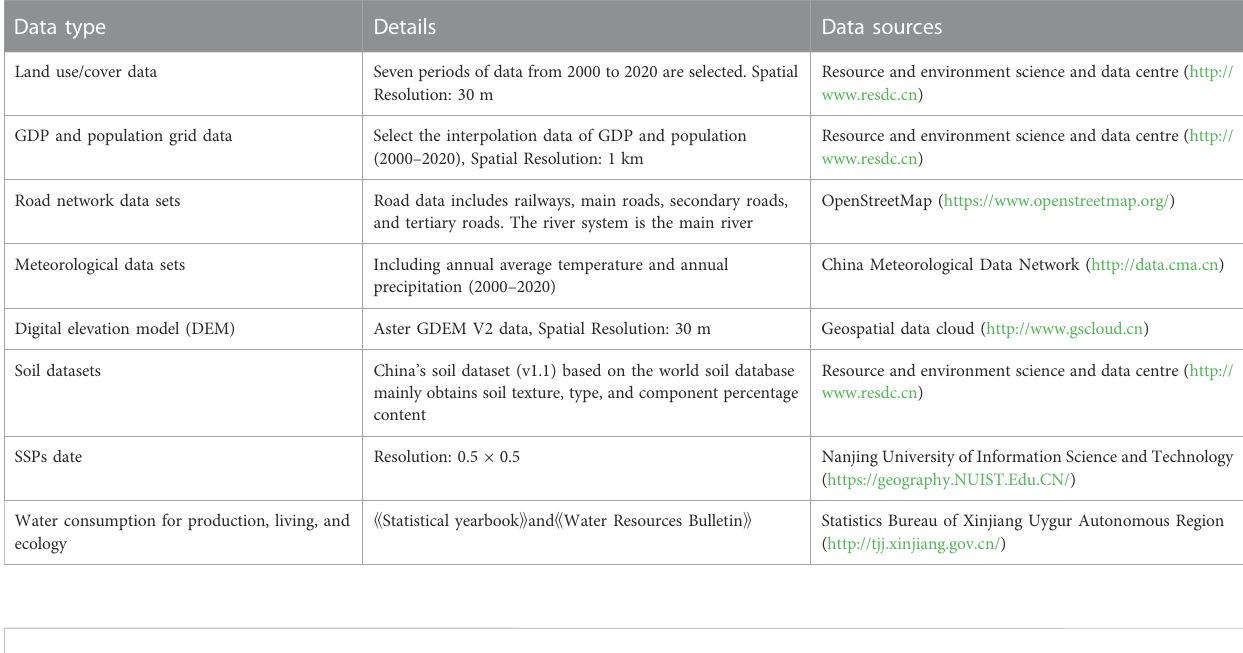
TABLE 1 Data type and sources.